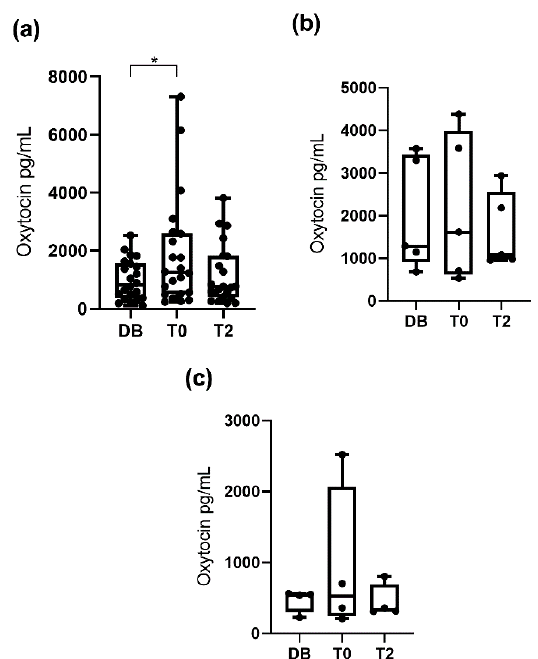
Figure 3. Changes in salivary oxytocin concentrations measured with AlphaLISA monoclonal assay at di ff erent times: the day before ejaculate collection (DB), immediately after starting the ejaculation (T0) and two hours after ejaculation (T2). Figure ( a ) shows the data for boars with libido intensity of 3 and ( b , c ) those with libido intensity of 2 and 1, respectively. The plots show medians (line within box), 25th and 75th percentiles (boxes), min and max values (whiskers) and individual data points. Asterisk indicate di ff erences between times (* p ≤